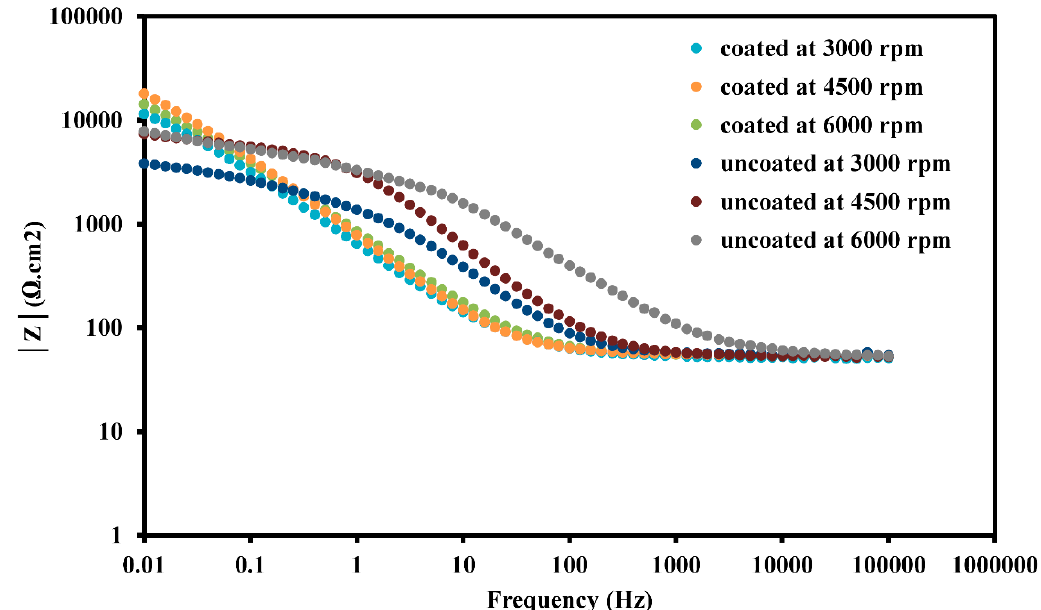
Figure 6. Comparison of the Bode impedance plots of the Cr 3 C 2 –NiCr-coated and uncoated SS316 samples at different rotation speeds.